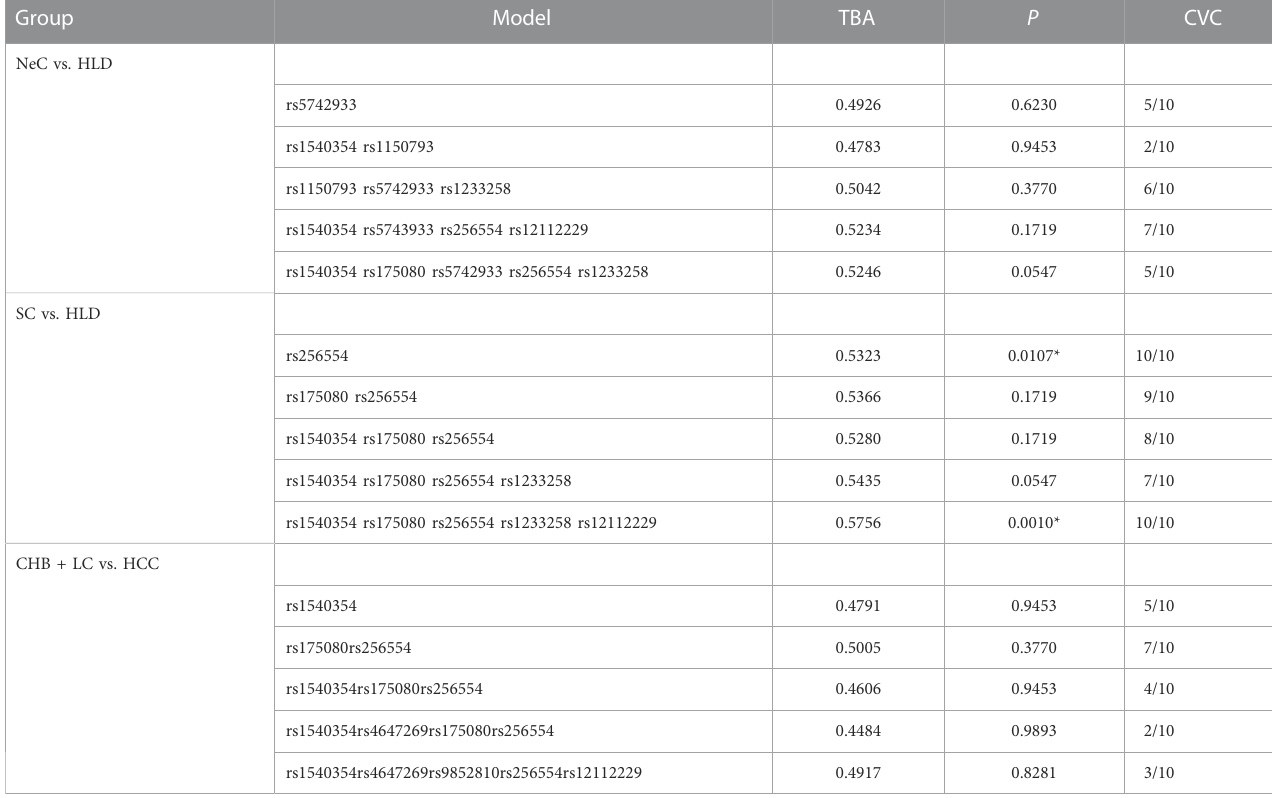
TABLE 3 Generalized multifactor dimension reduction analysis of 11 loci in NeC vs. HLD, SC vs. HLD and CHB + LC vs. HCC groups by GMDR (v0.9). Group